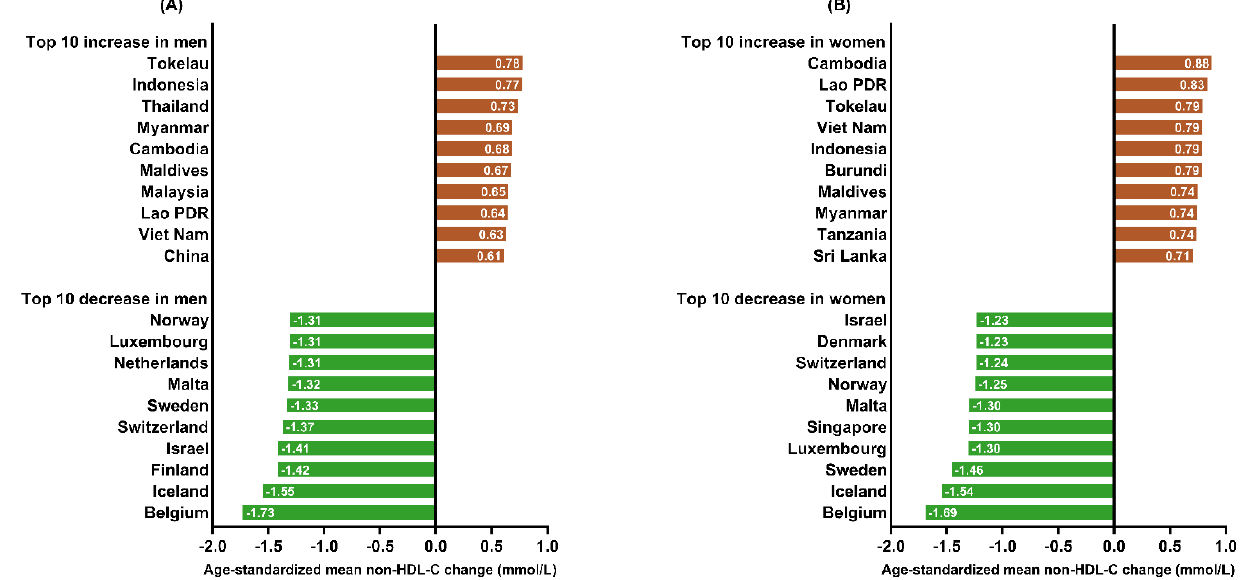
Figure 2. Top 10 countries with the largest increases and decreases of age-standardized mean non- HDL-C levels from 1980 to 2018 for men and women. ( A ), Top 10 countries with the largest increase and decrease of age-standardized mean non-HDL-C in men. ( B ), Top 10 countries with the largest increase and decrease of age-standardized mean non-HDL-C in women. Data obtained from NCD- RisC study. Available online: https://www.ncdrisc.org (accessed on 1 July 2022) [13]. Abbreviations: non-HDL-C, non-high-density lipoprotein